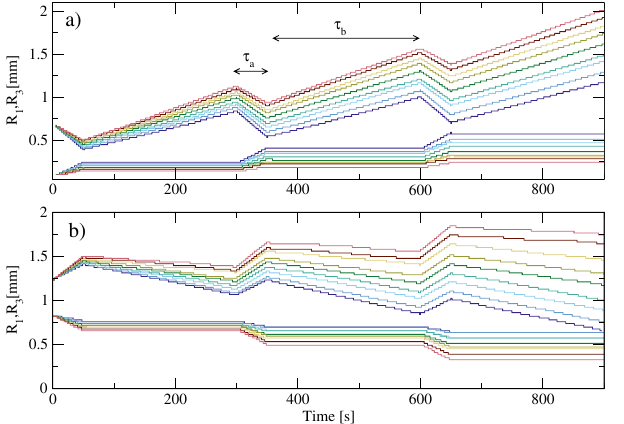
Figure 5. Ratcheting defect lines. R 1 (bottom lines) and R 3 (top lines), in mm, vs time in samples with B = 16 mT for alternating drive intervals with bias F ba applied for τ a = 50 s and F bb applied for τ a = 250 s during each cycle. ( a ) Forward ratchet effect for ( F ba , F bb ) values of ( − 0.18, 0.76), ( − 0.16, 0.77), ( − 0.14, 0.78), ( − 0.12, 0.79), ( − 0.10, 0.8), ( − 0.08, 0.81), ( − 0.06, 0.82), ( − 0.04, 0.83) and ( − 0.02, 0.84), from blue to red. ( b ) Reverse a , F b ) values of (0.96, 0.22), (0.98, 0.23), (1.0, 0.24), (1.02, 0.25), (1.04, 0.26), (1.06, 0.27), ratchet effect for ( F b b (1.08, 0.28), (1.1, 0.29) and (1.12, 0.3), from blue to